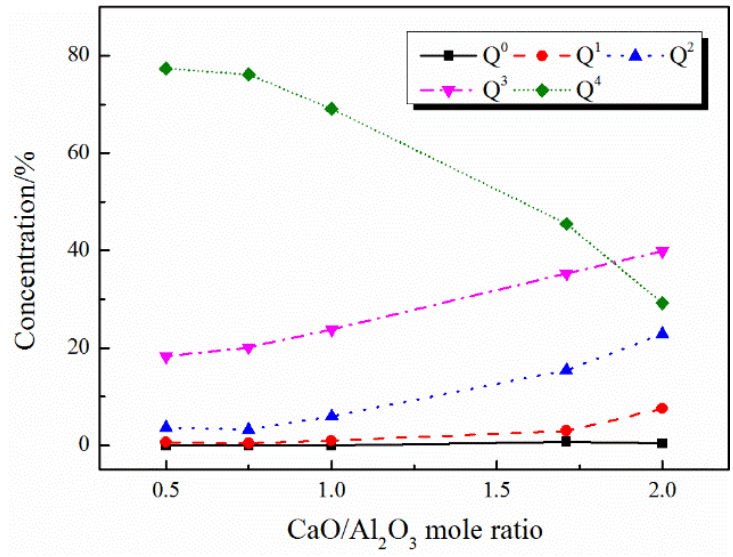
Figure 6. Distribution of Q n (Al) species in CaO – Al 2 O 3 melts with different CaO/Al 2 O 3 mole ratios.